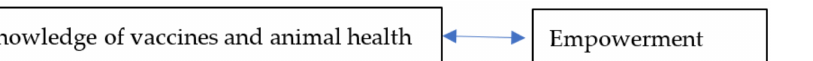
Figure 5. Illustration of the PLS-SEM model results on the relationship between knowledge (of vaccines and animal health) and empowerment.